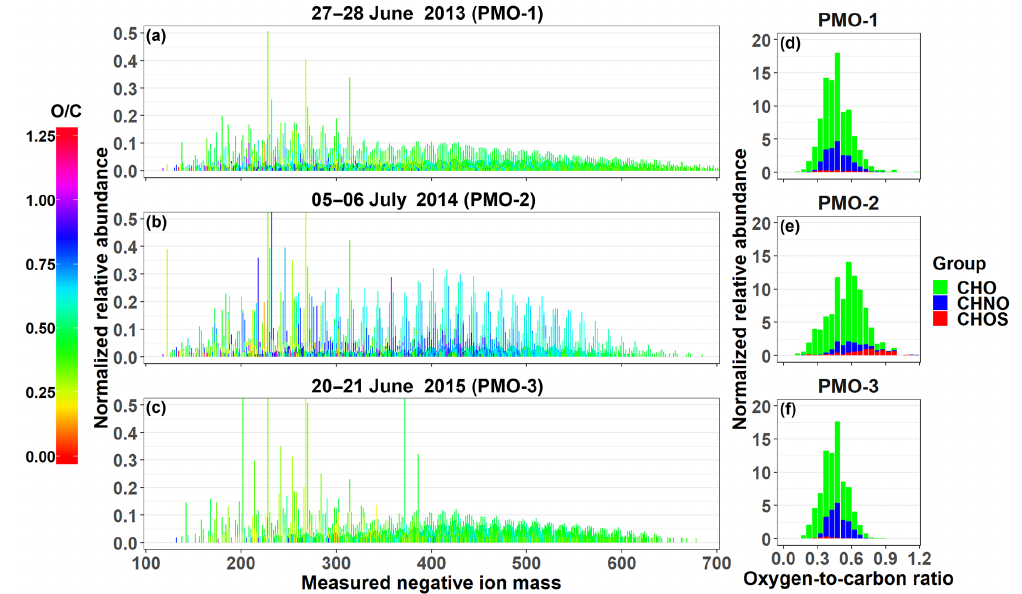
Figure 2. Reconstructed negative ion mass spectra (a–c) and O / C histograms (d–f) for the three PMO samples. The color in the mass spectra indicates the O / C value for the molecular formula it represents. The tallest peaks in the mass spectra in (b) and (c) exceed the range, this was done to improve the visibility of the lower abundance species (see also Fig.